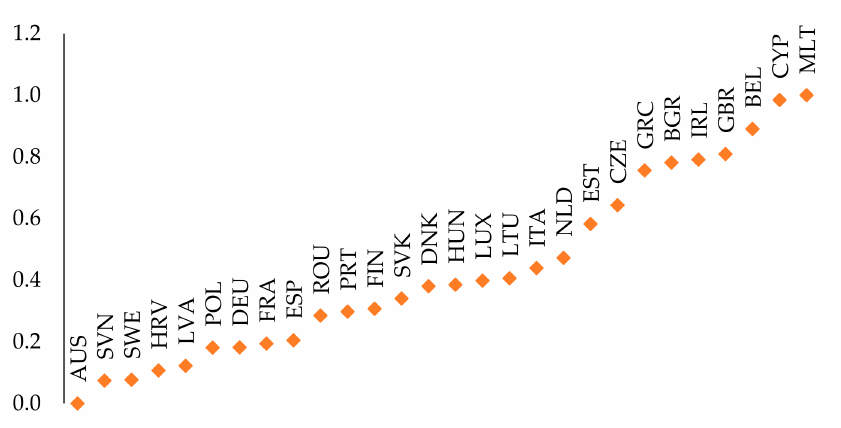
Figure A2. Linear ordering of the EU countries on the basis of coefficients of exponential trends.